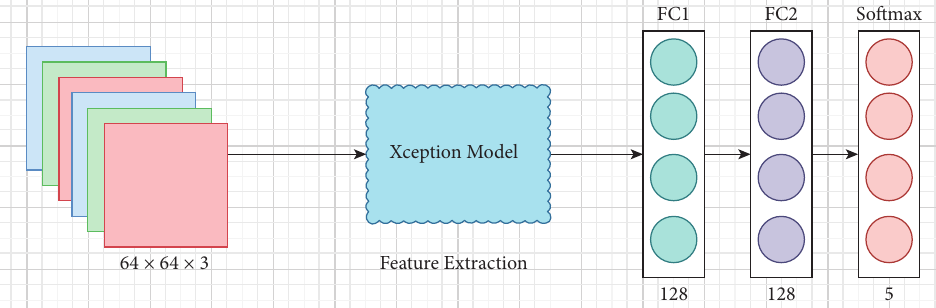
Figure 6: Xception model as transfer learning model used for feature